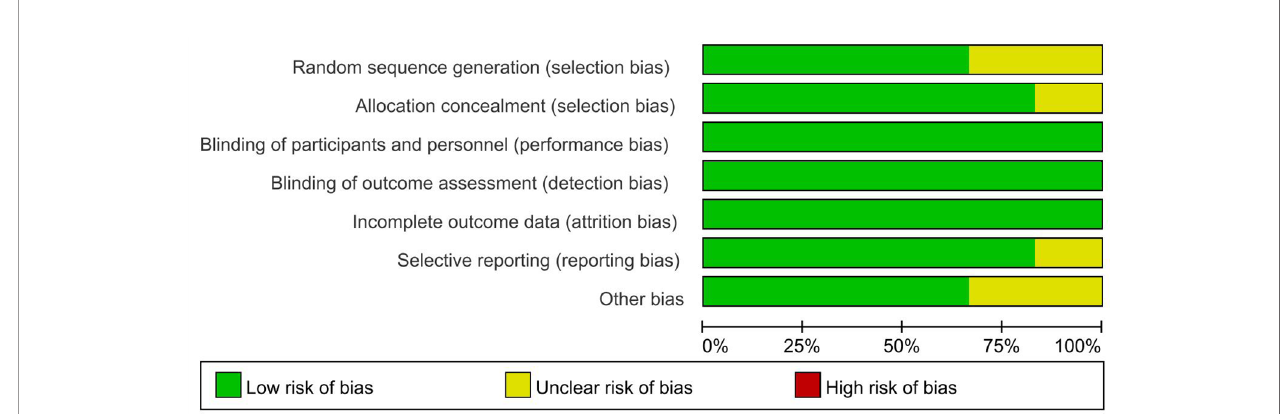
FIGURE 2 | Risk of bias